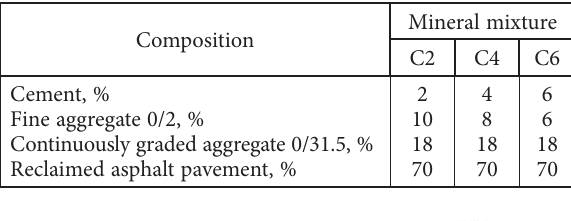
Table 1. The composition of Mineral-Cement-Emulsion